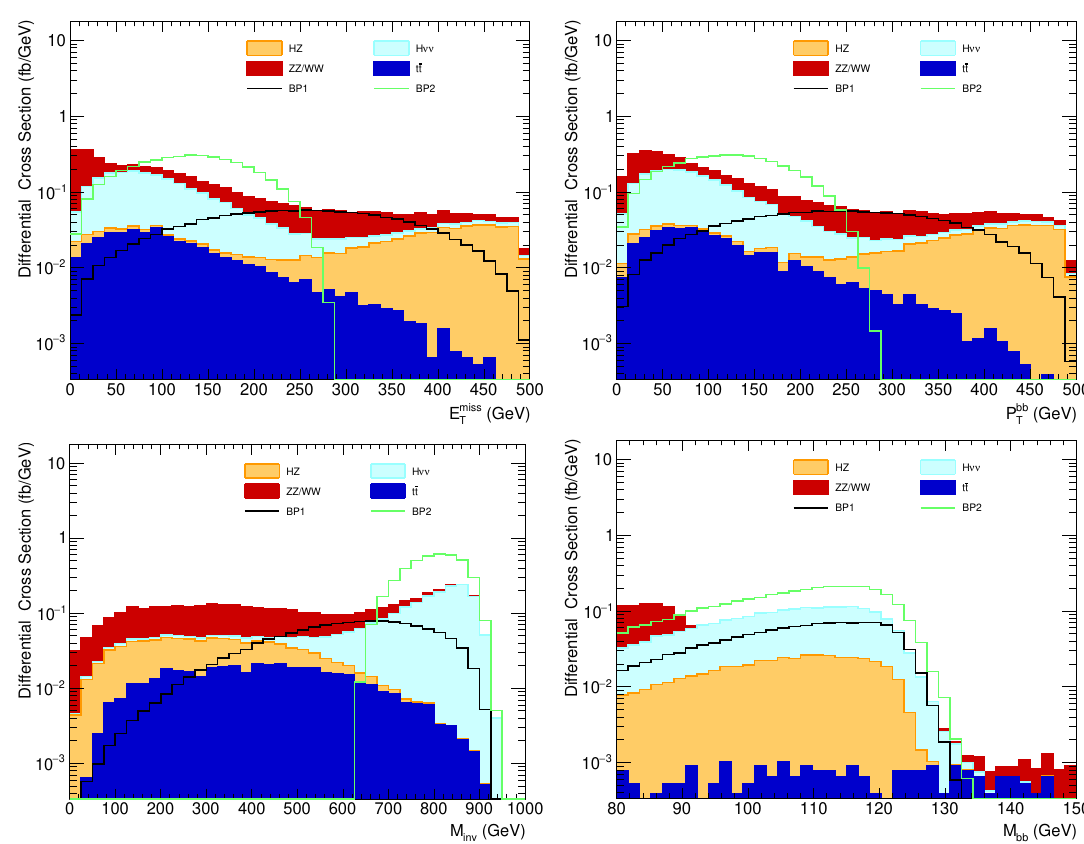
Figure 5 . Differential cross sections for some selected observables used in the signal-to-background √ discrimination in e + e − → H + E miss process at ] = s = 1000 GeV, and assuming [ P , P e + e − T [+80% , − 20%] . From top left to bottom right, we display the missing transverse energy ( E miss ), the T transverse momentum of the b ¯ b system ( p b ¯ b ), the invisible invariant mass ( M ), and the invariant inv T mass of the b ¯ b system ( M ). We show the distributions for HZ (orange), diboson ( ZZ/WW ), b ¯ b Hν e ¯ ν e (cyan) and t ¯ t (blue). For comparison, we show the differential cross sections for two signal benchmark points: BP1 corresponding to m = 1000 GeV, and m = 20 GeV (black line) and BP2 N H ± corresponding to m = 460 GeV, and m = 320 GeV (green line). The distributions are shown N H ± after the first two basic